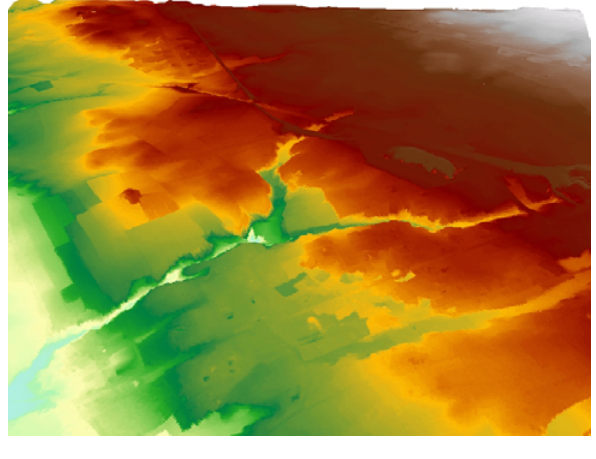
Figure 11. 3Dview of DEM